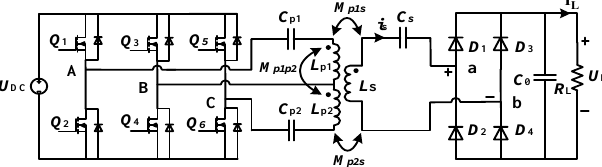
Figure 3. Three-bridge arm-switching IPT system structure.